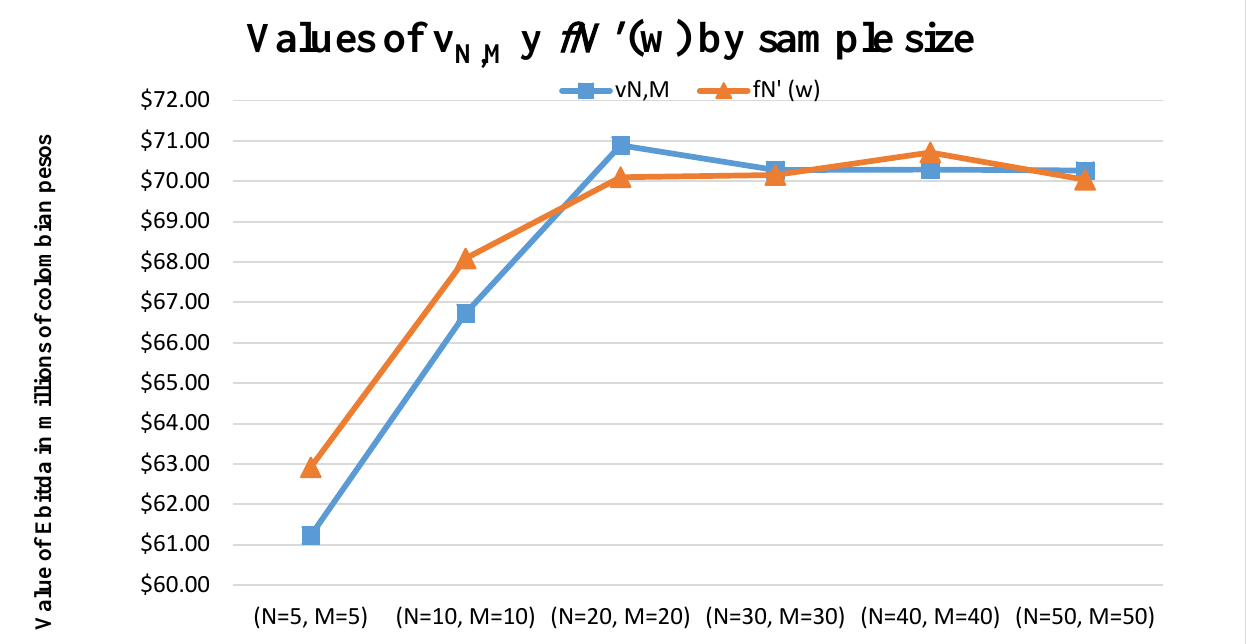
Fig. 1. Values of